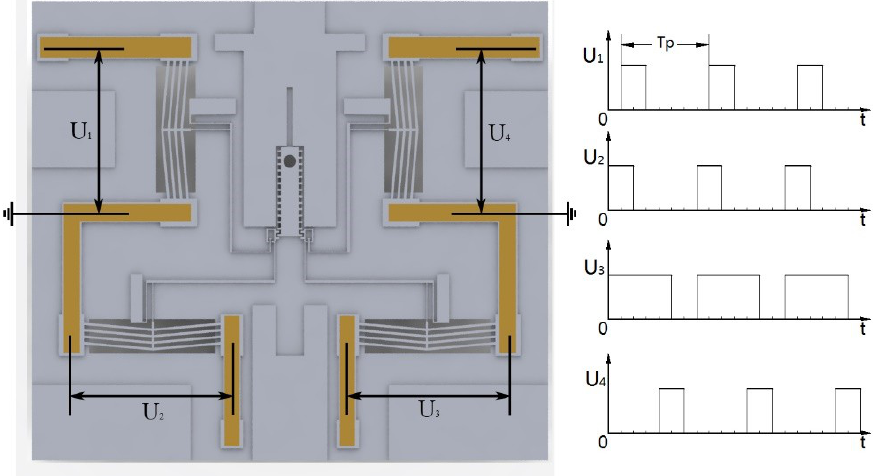
Figure 7. The driven signal of the actuation chip.